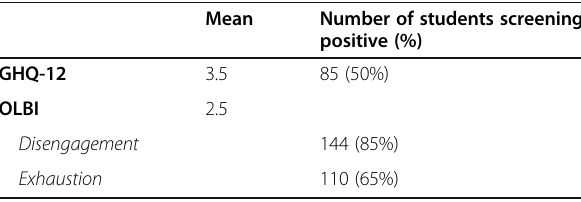
Table 3 GHQ and OLBI positivity